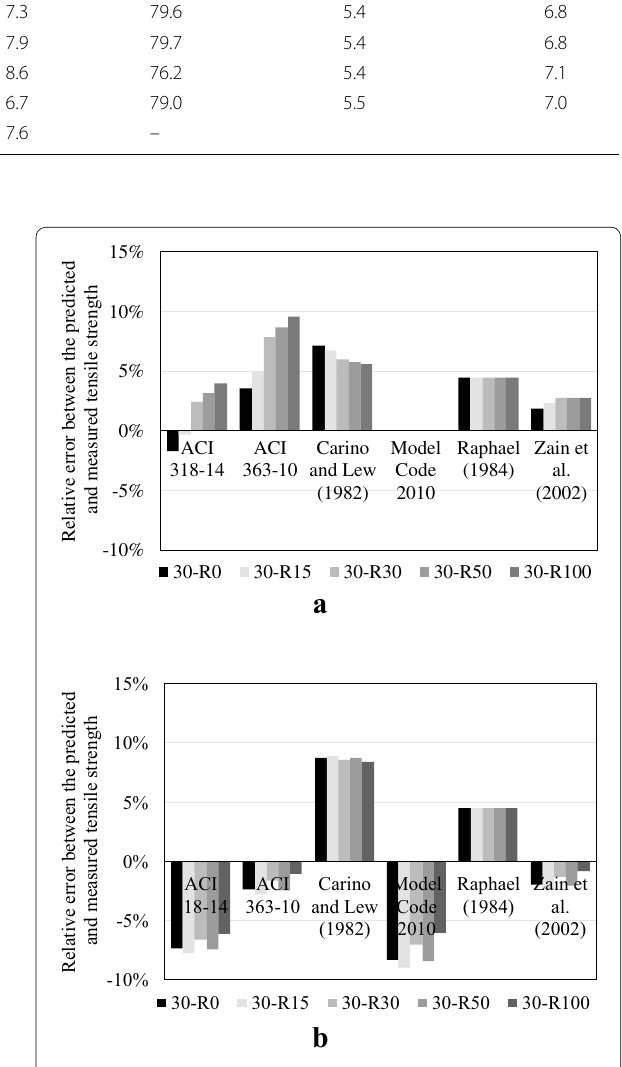
Fig. 8 Comparisons between the code and the previous equations for the test results for (a) NS concrete, and (b) HS